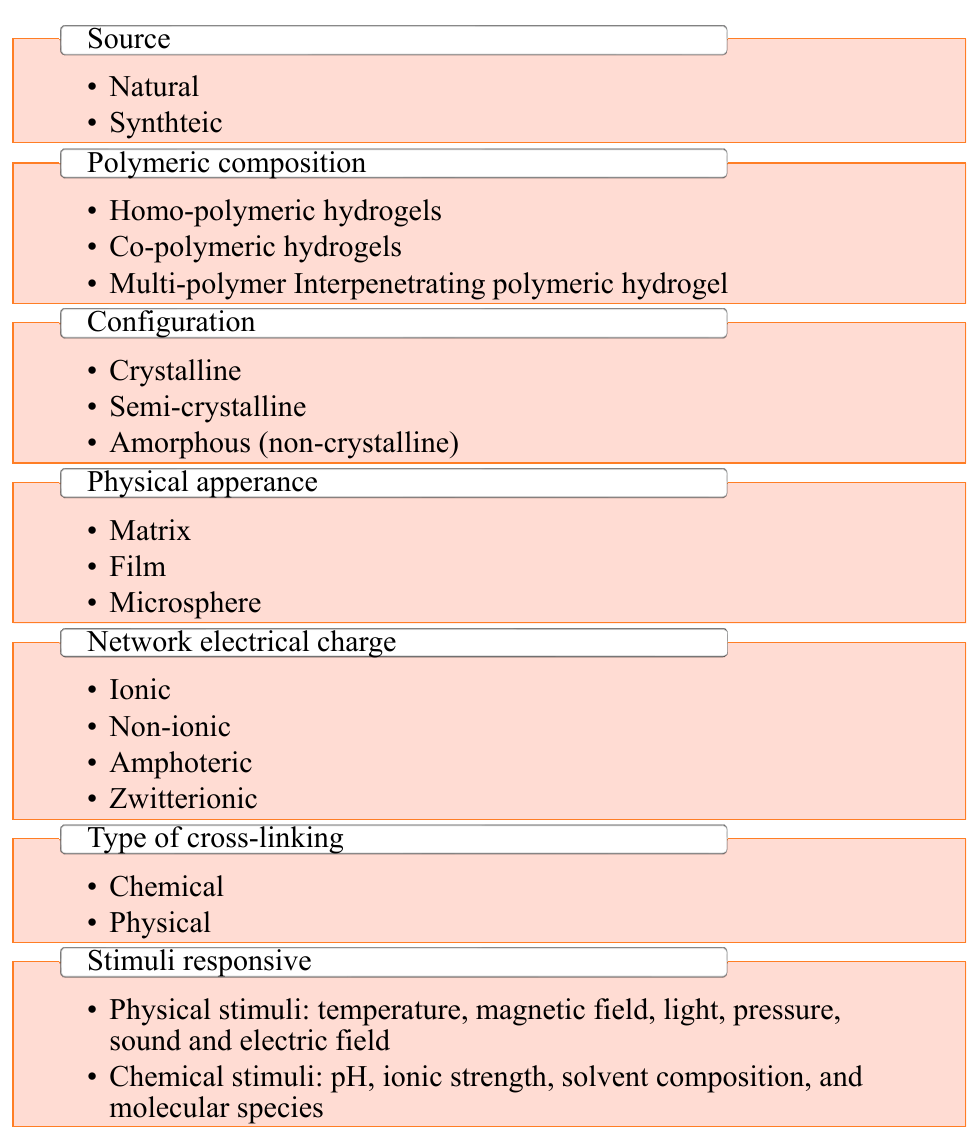
Figure 1. Detailed representation of classification of hydrogels.